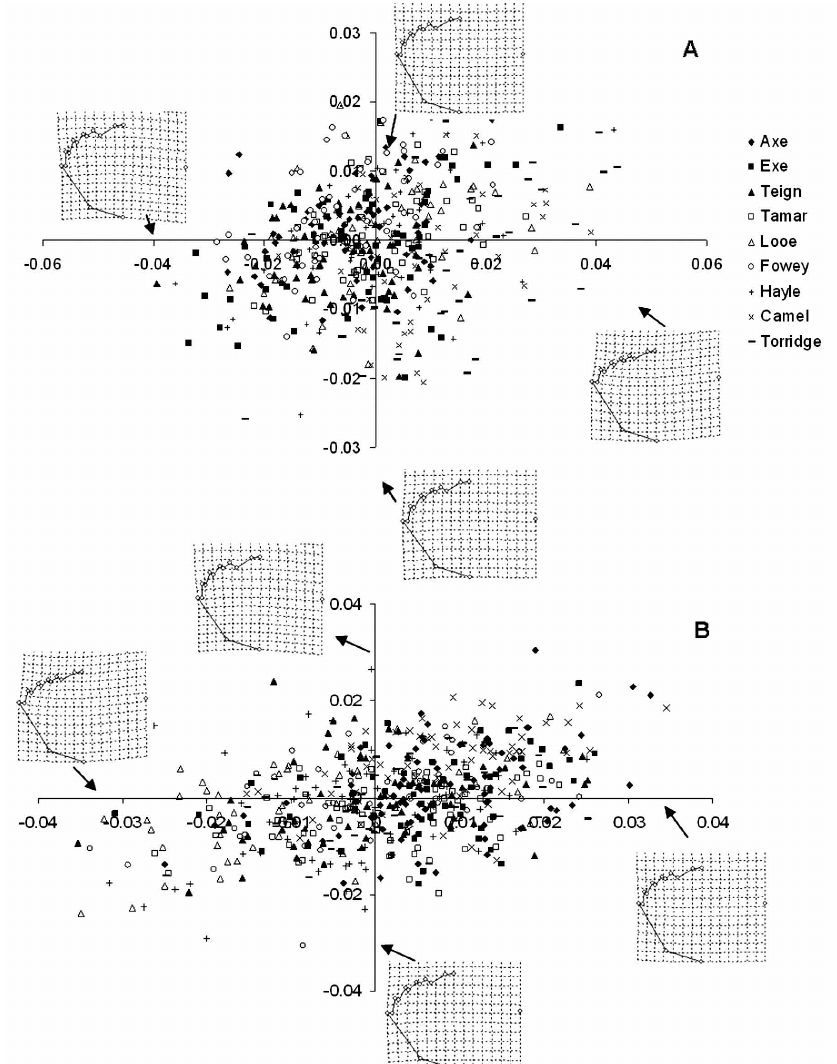
Fig . 4. – Scatterplot of individual scores from the relative warp analysis. Grids show deformation from consensus configuration of the cara- pace of Carcinus maenas males (A) and females